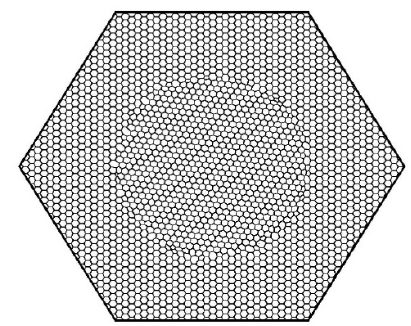
Figure 1. A photographic picture of a 2D wet foam containing a loop grain boundary.